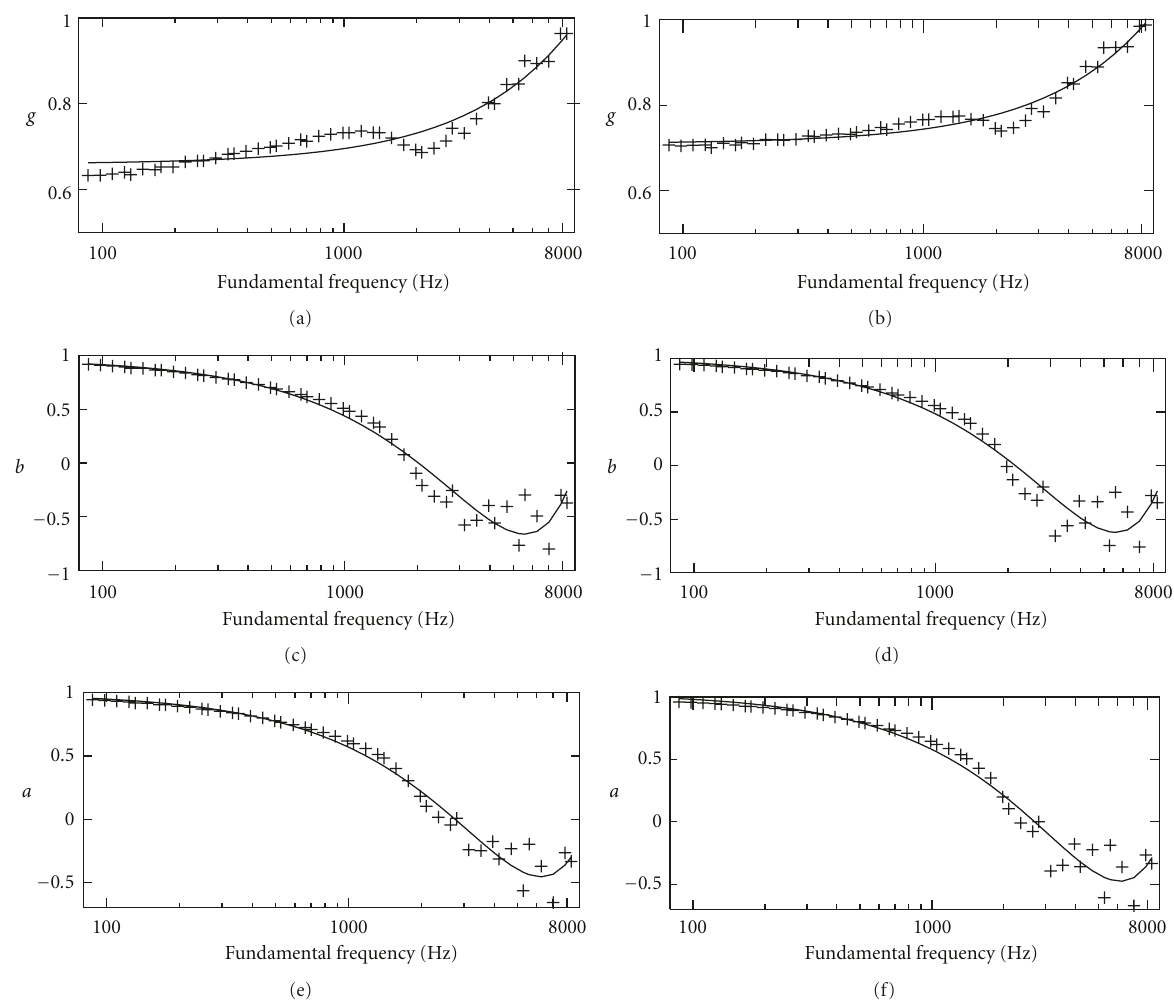
Figure 9: The gain factor g , the filter zero b , and the filter pole a estimates (plus signs) for (a), (c), and (e) the third-order B-spline BLIT and (b), (d), and (f) the fourth-order B-spline BLEP, respectively, and the polynomial approximations of the filter parameters (solid lines). Table 3: Coe ffi cients of the polynomial fits for the first-order post- equalising filter parameters for the ideally bandlimited sawtooth oscillator. c